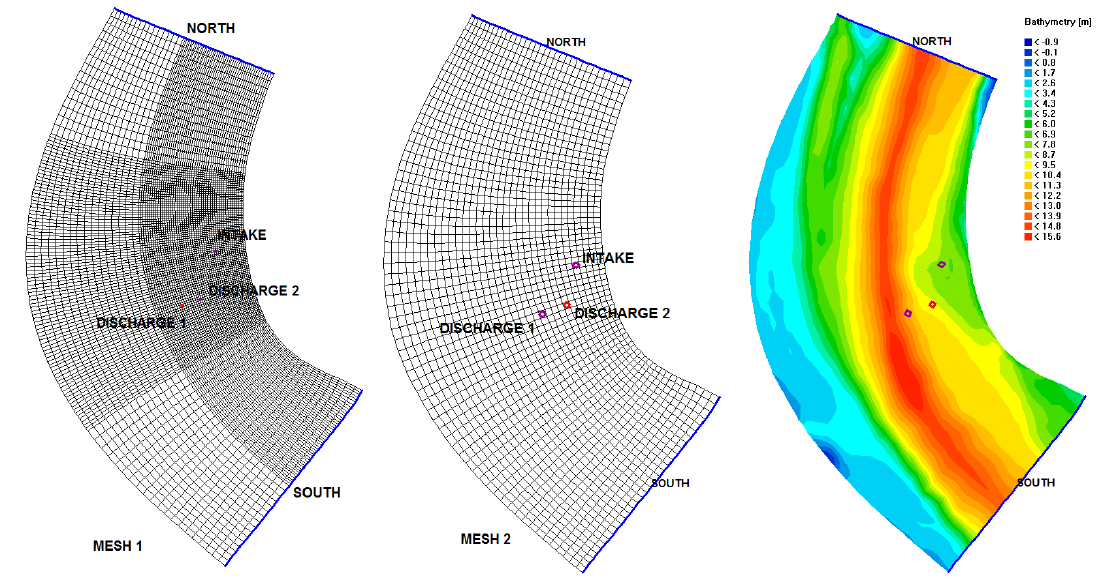
Figure 3. Nested domain grid cell resolution, bathymetry, boundaries and location of